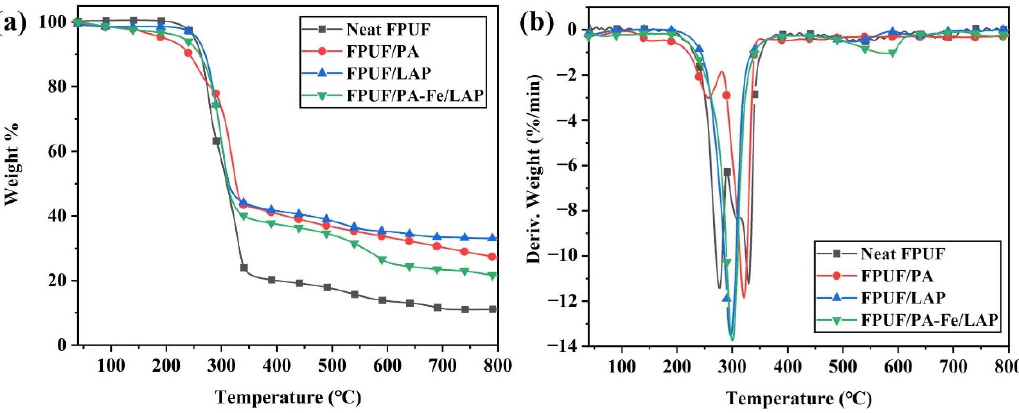
Figure 5. TG ( a ) and DTG ( b ) curves of neat FPUF, FPUF/PA, FPUF/LAP, and FPUF/PA-Fe/LAP in air. Table 2. Summary of TG data for neat FPUF, FPUF/PA, FPUF/LAP, and FPUF/PA-Fe/LAP in